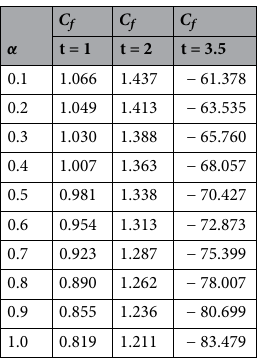
Table 7. Statistically analysis of Skin friction for the effect of fractional